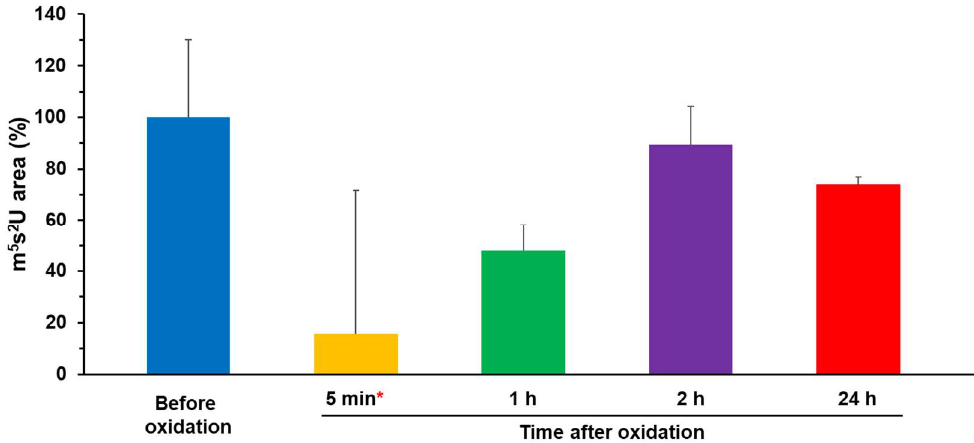
Figure 2. tRNA-thiolation activity assay of [3Fe–4S]-TtuA and [4Fe–4S]-TtuA. Activity assay of [3Fe–4S]-TtuA and [4Fe–4S]-TtuA in the absence of K 3 [Fe(CN) 6 ]. The tRNA-thiolation activity of TtuA before oxidation was normalized to 100%. All data are presented with standard deviation values (N = 3, red asterisk (*): one time was measured from a different lot and scaling by the activity of [Before oxidation]). The quantification result of this assay is shown in Table 2. Table 2. Biochemical quantification of the enzymatic activity of [3Fe–4S]-TtuA and [4Fe–4S]-TtuA. Time after Oxidation Enzymatic Activity without K 3 [Fe(CN) 6 ] Before oxidation